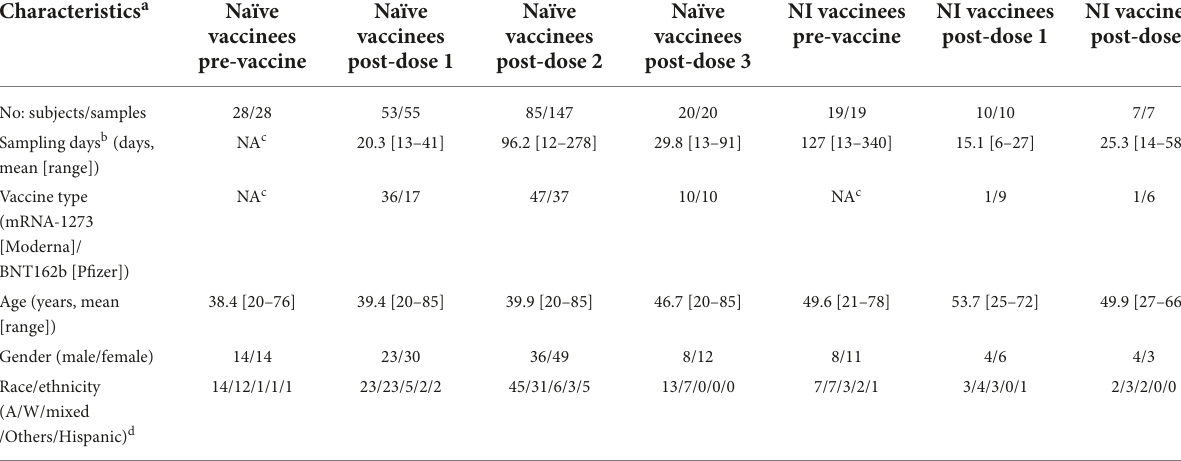
TABLE 1 Characteristics of study